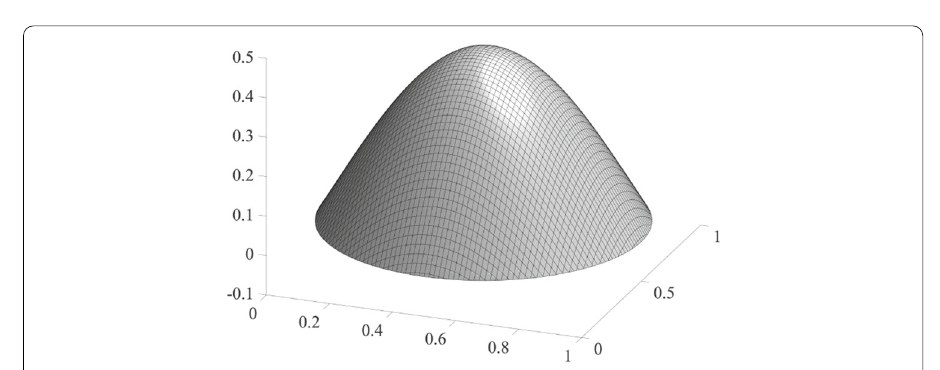
Fig. 7 Elevation of the discrete solution on one of the meshes in the